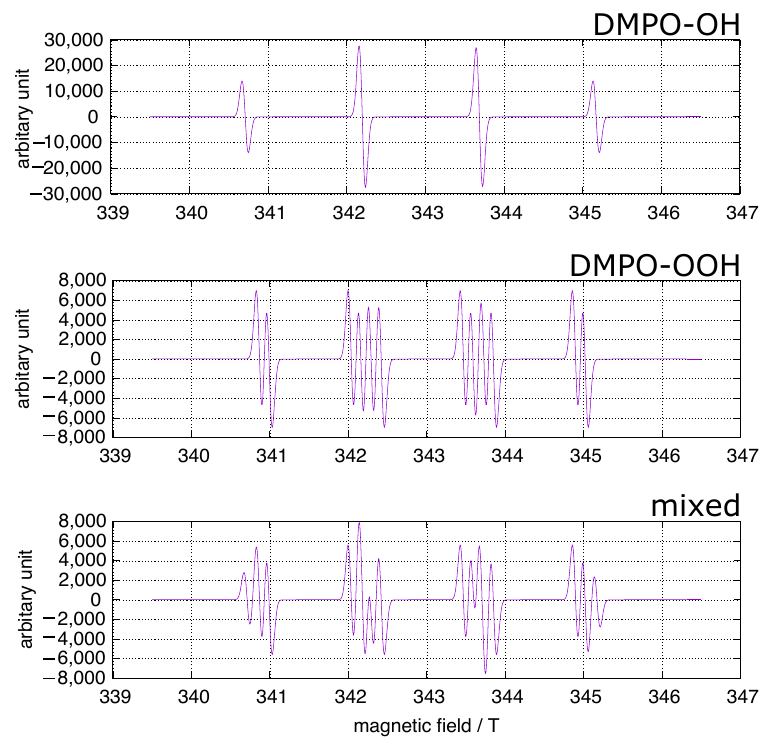
Figure 1. DMPO spin trapping. The simulation was performed using EasySpin software [26]. upper: DMPO-OH, hyperfine splitting constants (mT): A N = 1.49, A H = 1.48; middle: DMPO-OOH, hyperfine splitting constants (mT): A N = 1.43, A β